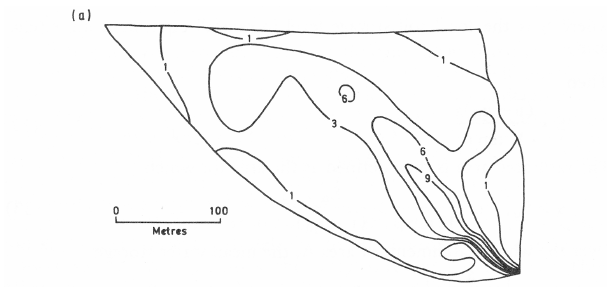
Figure 1. Distribution of the topographic index (a/ tan β) for the upper East Twin catchment, Mendips, UK (from Kirkby, 1975, with permission from Pearson